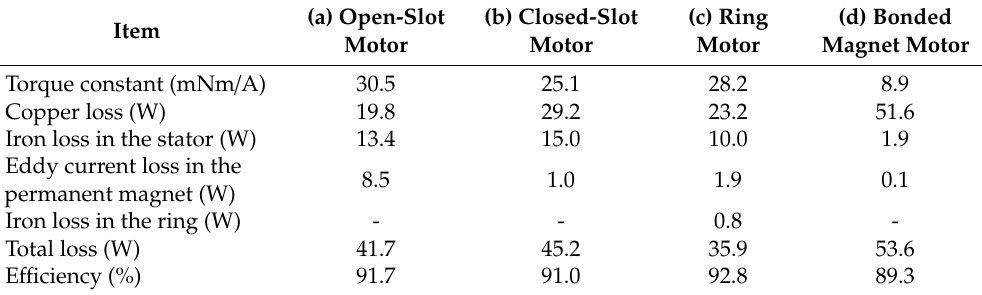
Table 5. Motor loss analysis results ( N = 30,000 rpm, P o = 500 W).